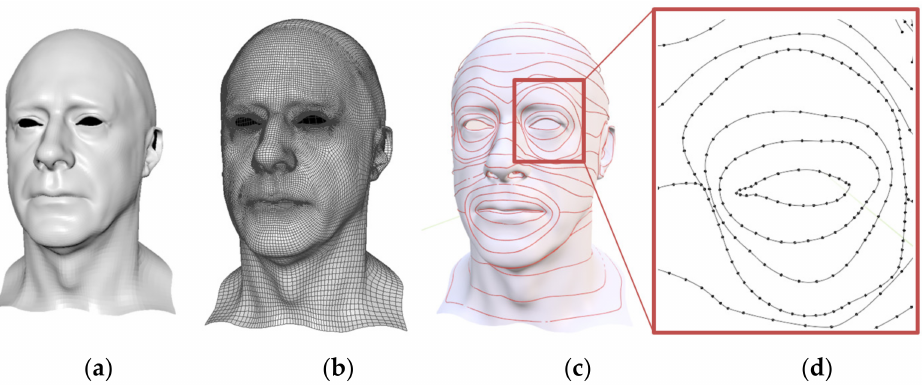
Figure 5. Extracting correspondent curves from 3D models. ( a ) Male model (mesh), ( b ) male model (with wireframe), ( c ) face model (with extracted curves), ( d ) local view of the extracted curves in the left eye